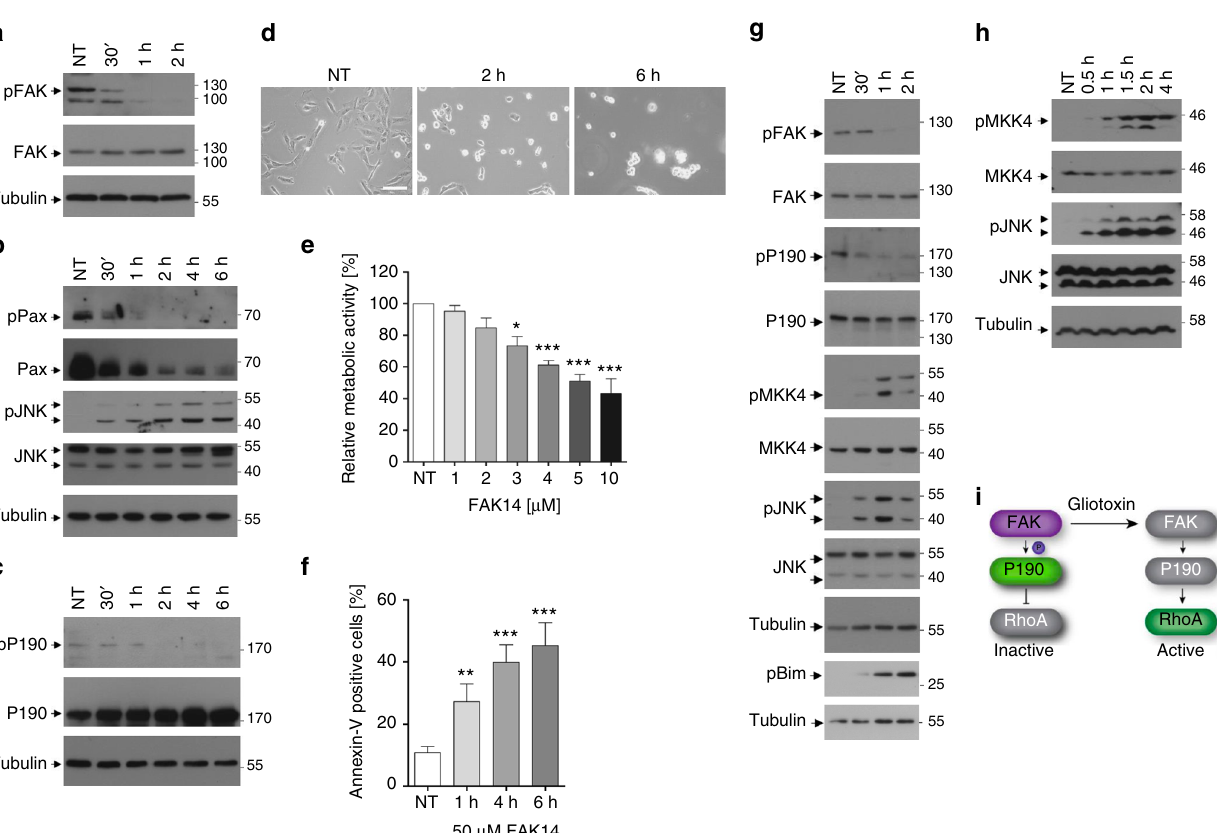
Fig. 5 FAK and p190RhoGAP are inactivated by GT. a Western blot analysis of total extracts of BEAS-2B cells either untreated (NT) or treated with 1 µ M GT for the indicated time periods showing that the activating phosphorylation of FAK at Y397 (pFAK) was lost within 1 h. b Paxillin (pPax) was dephosphorylated and degraded and JNK was phosphorylated/activated (pJNK) with the same kinetics as FAK inactivation. c Concomitantly, p190RhoGAP was also dephosphorylated at Y1105. d Treating BEAS-2B cells with 10 µ M of the speci fi c FAK inhibitor FAK14 caused rapid cell detachment within 6 h. Scale bar = 100 µ m. e , f Cell survival of BEAS-2B cells measured as relative metabolic activity using the XTT assay gradually decreased with increasing doses of FAK14 (0 – 10 µ M) ( e ). Concomitantly, 50 µ M FAK14 triggered cell death of BEAS-2B cells (as measured by annexin V-FITC staining) with similar time kinetics as GT ( f ). g Western blot analysis of total extracts of BEAS-2B cells either non-treated (NT) or treated with 50 µ M of FAK14 ( g ) or 10 µ M of FAK14 ( h ) for 30 min to 4 h. The inhibitor caused FAK and p190RhoGAP dephosphorylation and MKK4, JNK and Bim phosphorylations. Tubulin was used as loading control in a – c , g and h . i FAK is active in adherent epithelial cells causing the activation of p190RhoGAP by its phosphorylation at Y1105. This inactivates RhoA. In response to GT, FAK and p190RhoGAP get inactivated, therefore allowing RhoA activation. Graphs in e and f show the means of at least three independent experiments ± s.e.m.; p -values: *0.05 – 0.01, **0.01 – 0.001, ***<0.001, one-way ANOVA, post hoc: Bonferroni compared to